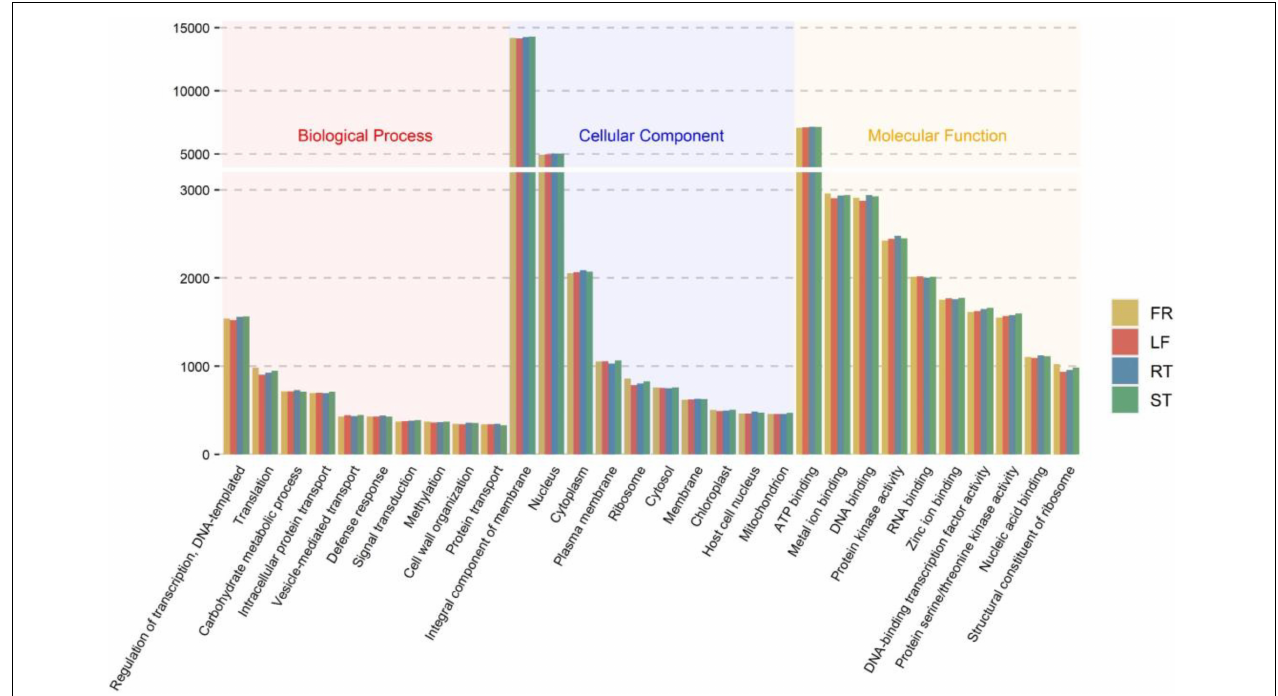
FIGURE 1 | GO classification of Trapa bispinosa